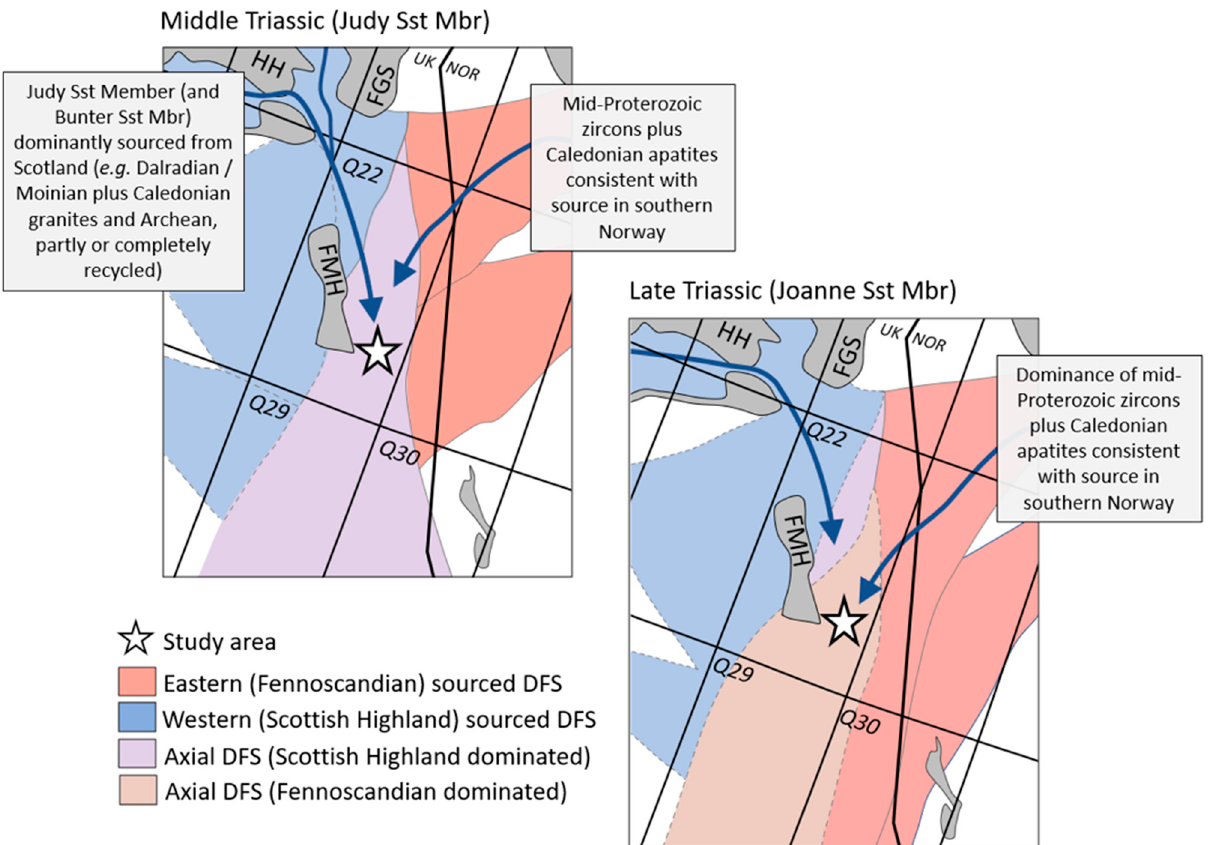
Figure 8. Inferred transport routes and likely source lithologies for Judy and Joanne sandstones in the Culzean-Marnock study area based on zircon and apatite data, overlain onto the schematic Middle and Late Triassic depositional systems described by Gray et al. [9].